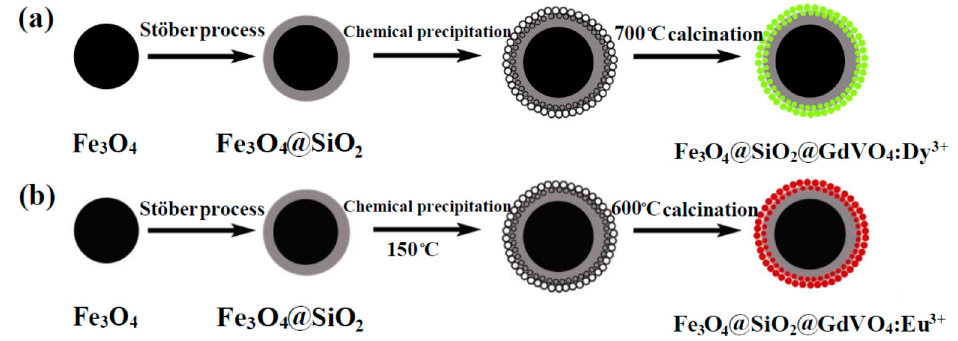
Figure 4. Illustration of the preparation process of ( a ) Fe 3 O 4 @SiO 2 @GdVO 4 :Dy 3+ and ( b ) Fe 3 O 4 @SiO 2 @GdVO 4 :Eu 3+ nanocomposites